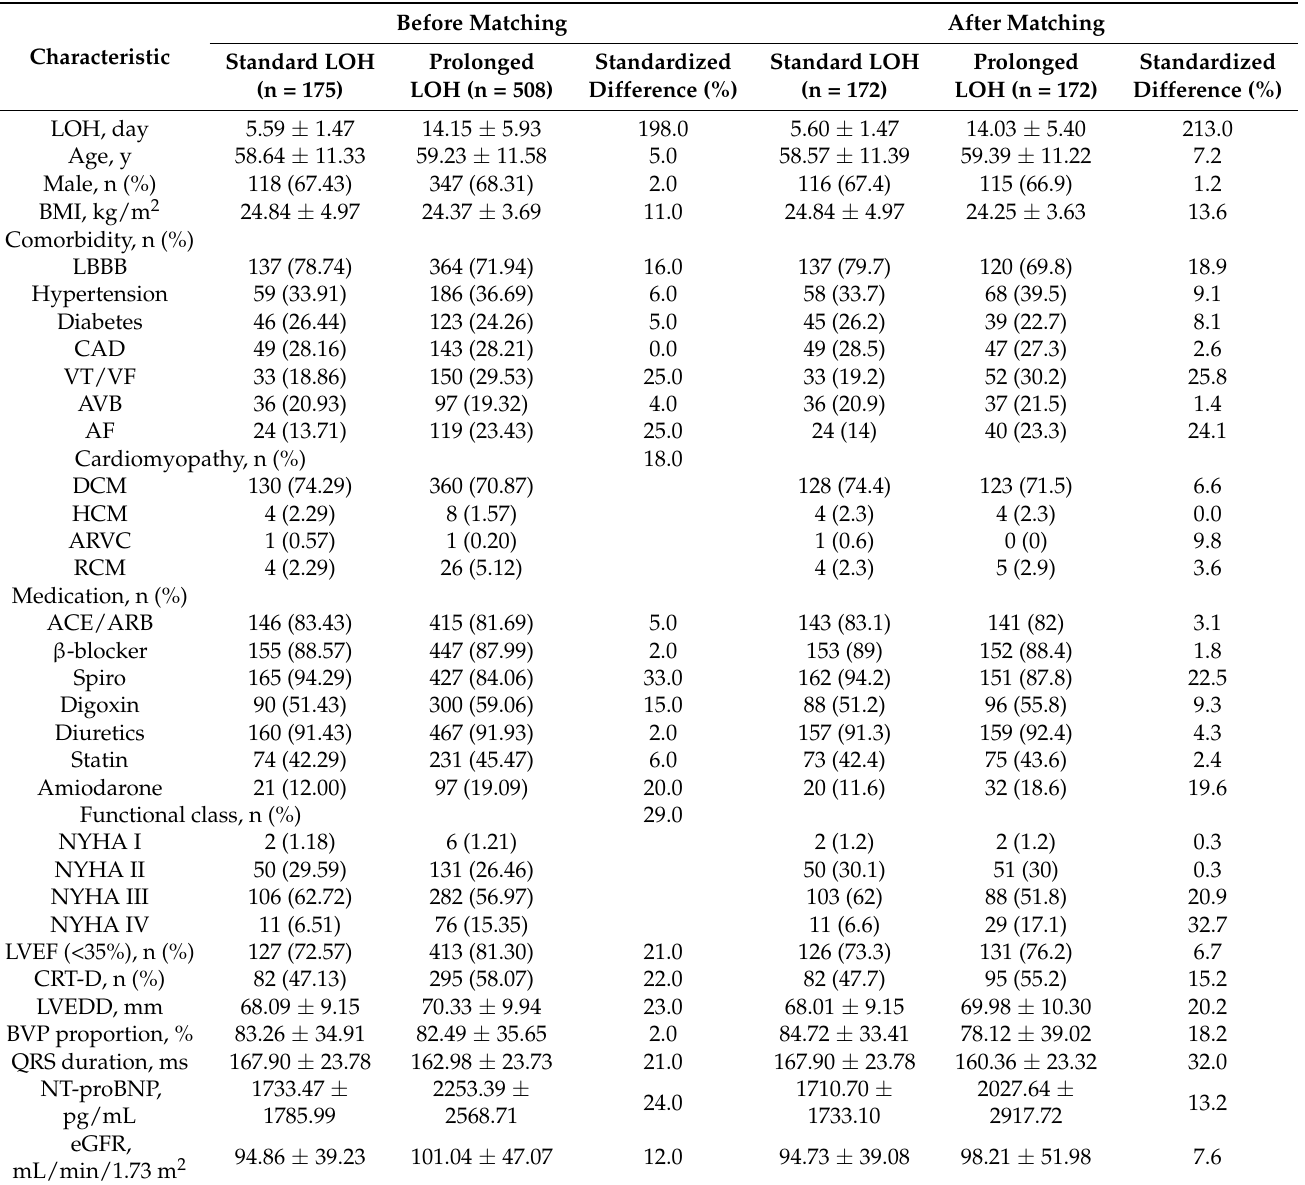
Table 1. Baseline characteristics before and after propensity score